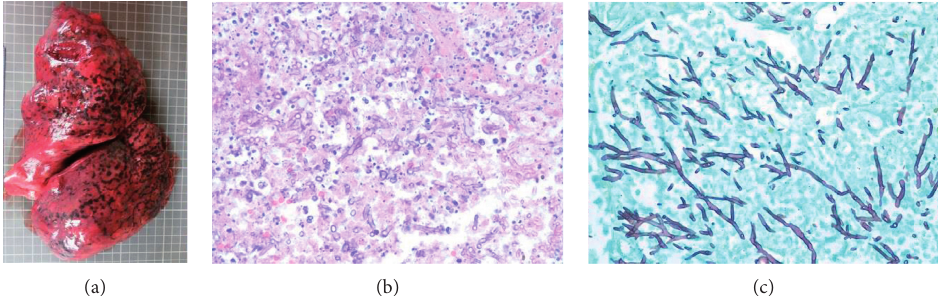
Figure 4: (a–c) Autopsy: invasive pulmonary aspergillosis. Left: macroscopic appearance of congested lung with infarcted and hemorrhagic areas; middle: hematoxylin-eosin (H&E) stain; right: Gomori methenamine silver (GMS)